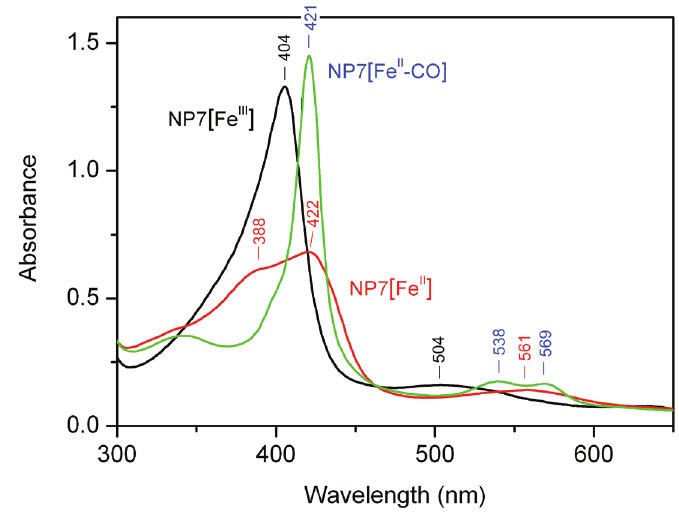
Figure S5. Absorption spectra of ferric and ferrous NP7 at pH 7.5. Black: NP7[Fe III ]; r ed : NP7[Fe II ]; blue: NP7[Fe II